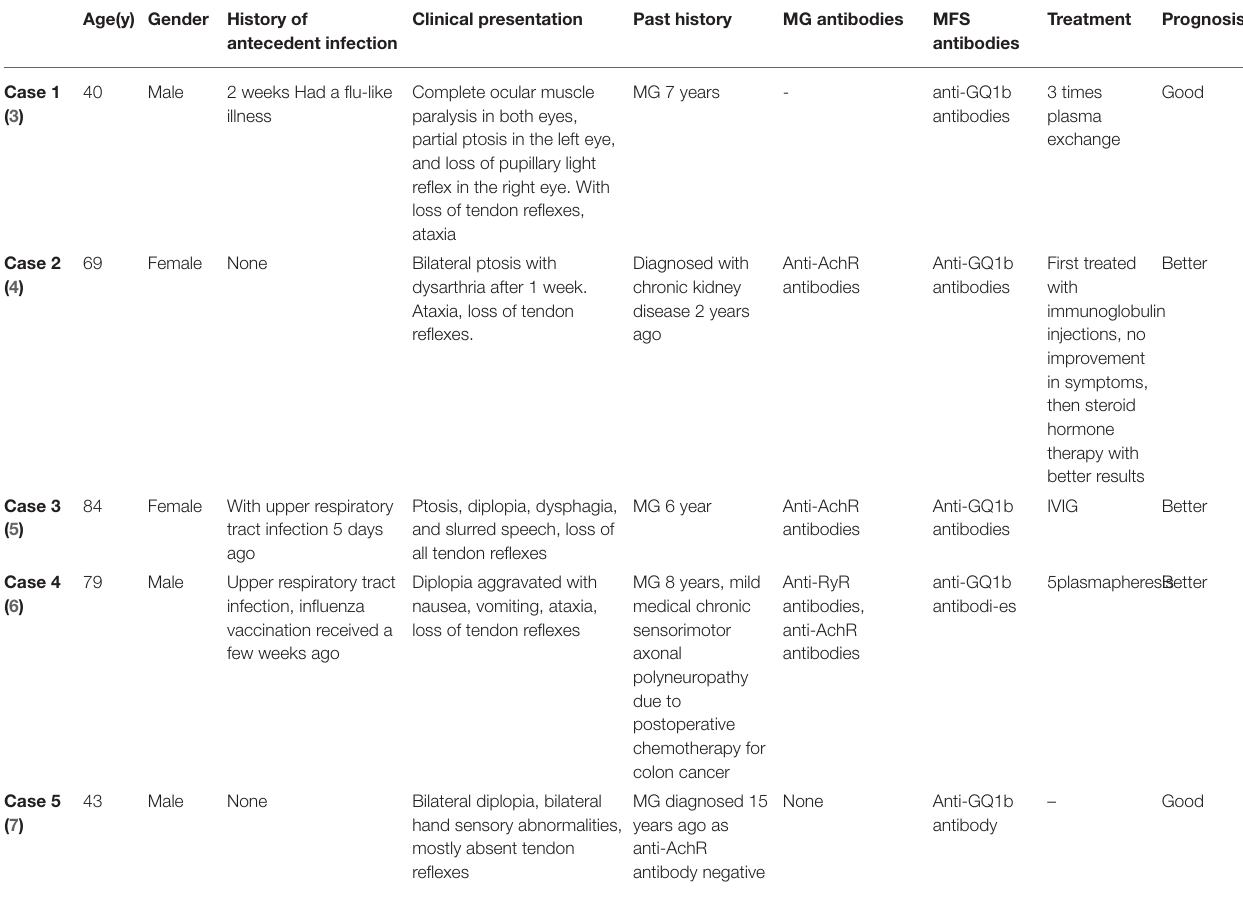
TABLE 1 | Characters of the five cases of overlapping MFS and MG. Age(y) Gender History of Clinical presentation Past antecedent infection